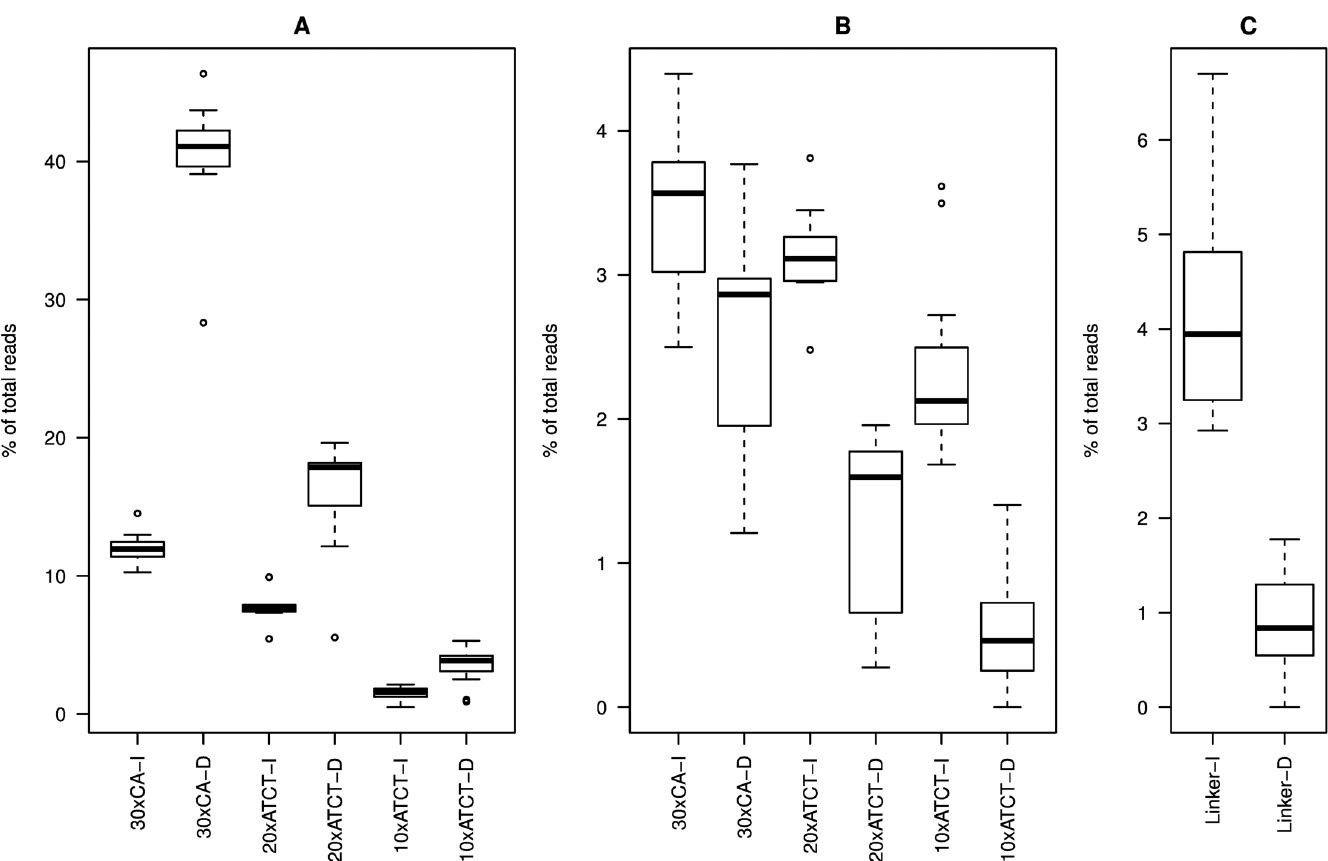
Fig 5. Directionality of indel mutation events. Percentages of non-target read lengths are on the y-axes, while the microsatellite structures and directionality of mutation events (I = insertion; D = deletion) are indicated on the x-axes. The boxes represent the inter-quartile range with the thick lines representing the medians. The whiskers are 1.5 times the inter-quartile range and outliers are plotted as individual dots. A. Stepwise mutations by integer numbers of repeat units. B. Non-stepwise mutations. C. Indel mutations by one or more bp in linker